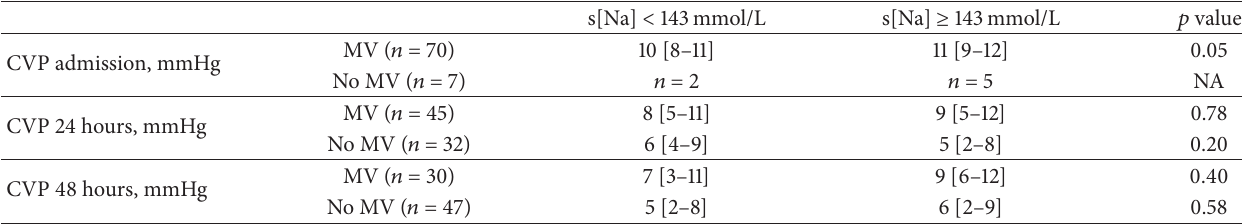
Table 3: Central venous